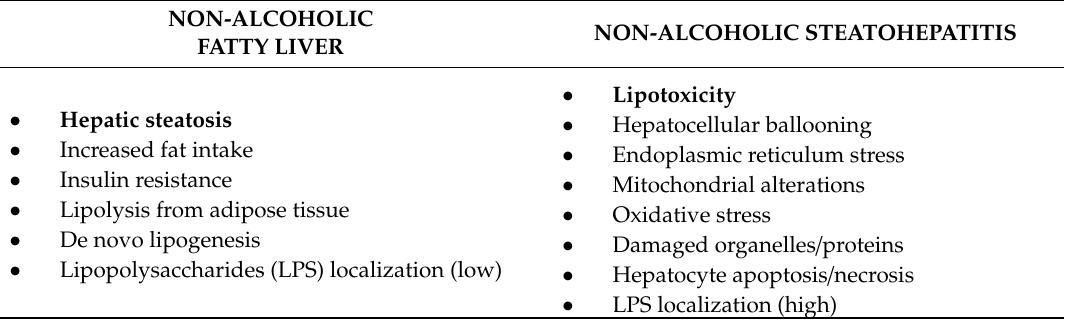
Table 1. Modifications in hepatocytes in